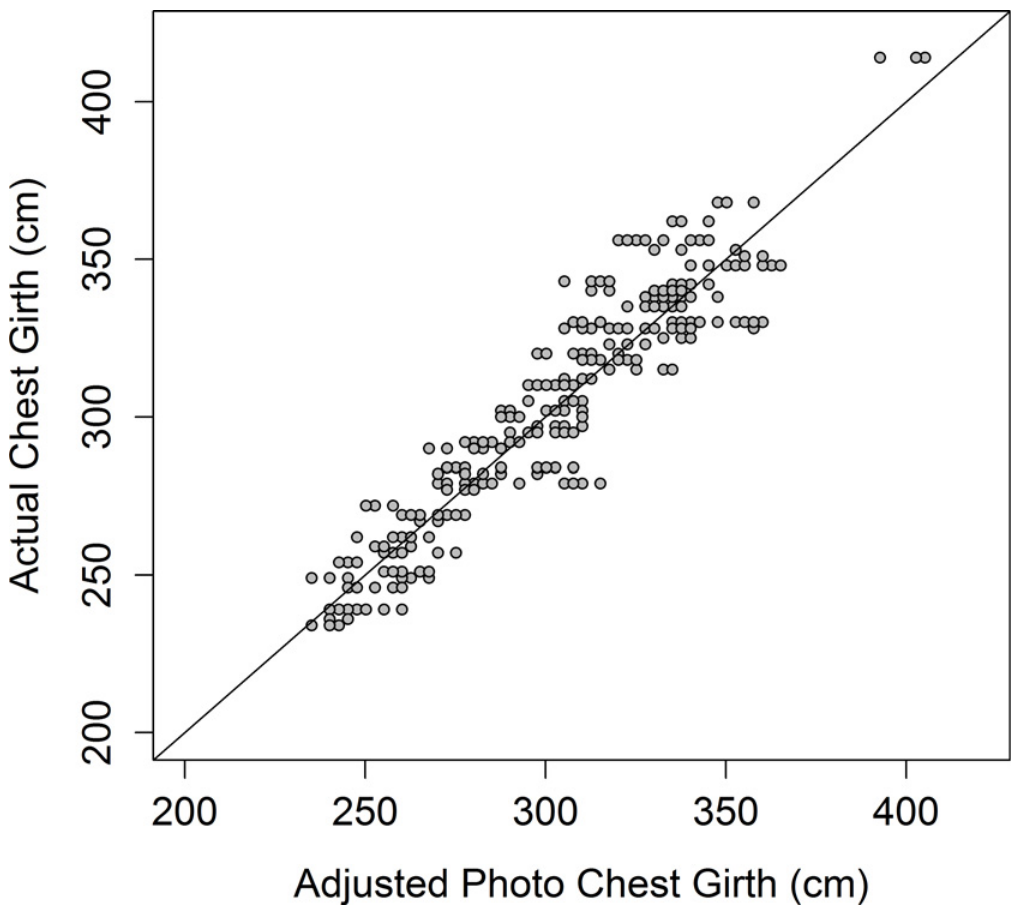
Fig 6. Predicted chest girth from photos (n = 78). Photographic measurements were adjusted by the equation 25.2 + 2.5 x Photo Girth . Dashed line represents 1:1 estimate:actual chest